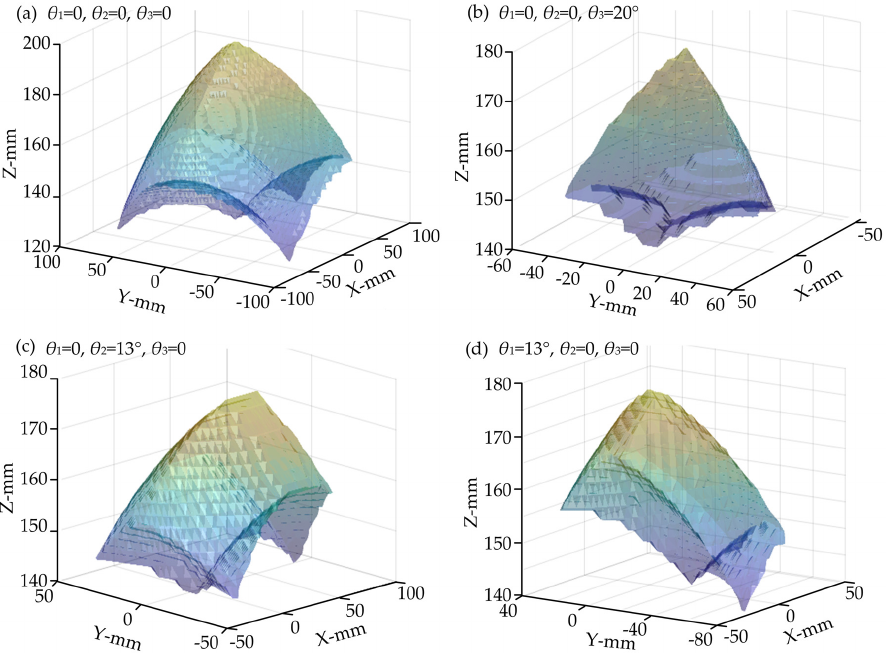
Figure 5. The position range of motion (ROM) of the external fixator. ( a ) The position ROM of the fixator when the orientation is (0,0,0). ( b ) The position ROM of the fixator when the orientation is (0,0,20). ( c ) The position ROM of the fixator when the orientation is (0,13,0). ( d ) The position ROM of the fixator when the orientation is (13,0,0).